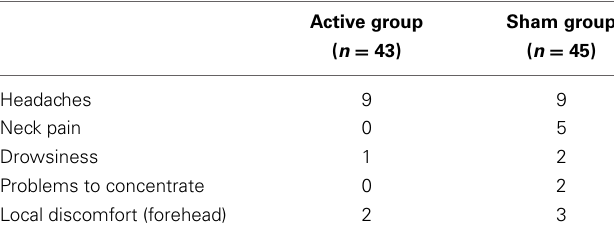
Table 3 | Frequencies of quoted rTMS side